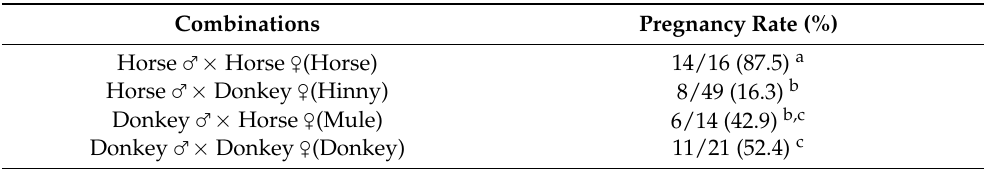
Table 1. Pregnancy rates according to the genotype of the conceptus in horse and donkey females inseminated with horse and donkey